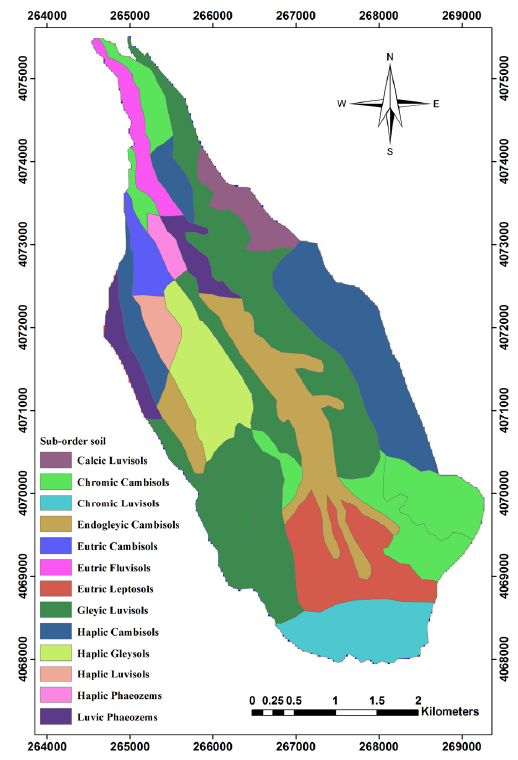
Figure 2. Classification of Sub ‐ order types of soil within the study area.